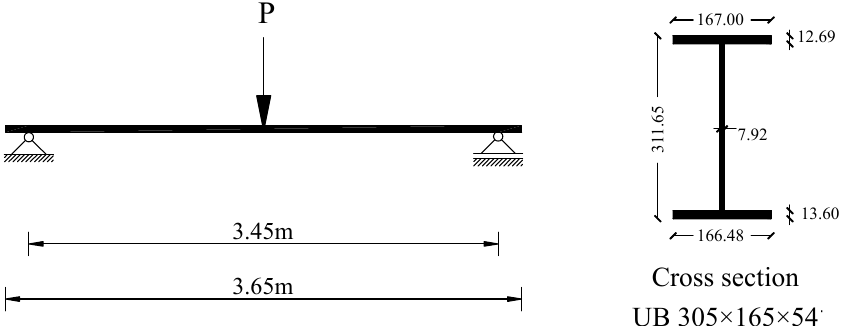
Figure 2. The structural system and the cross section (dimensions of the cross section in mm).